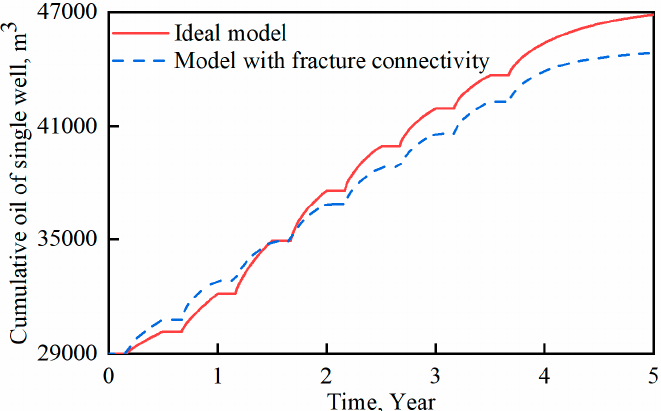
Figure 16. Comparison of cumulative oil production of the single well between the ideal model and the model with fracture connectivity.